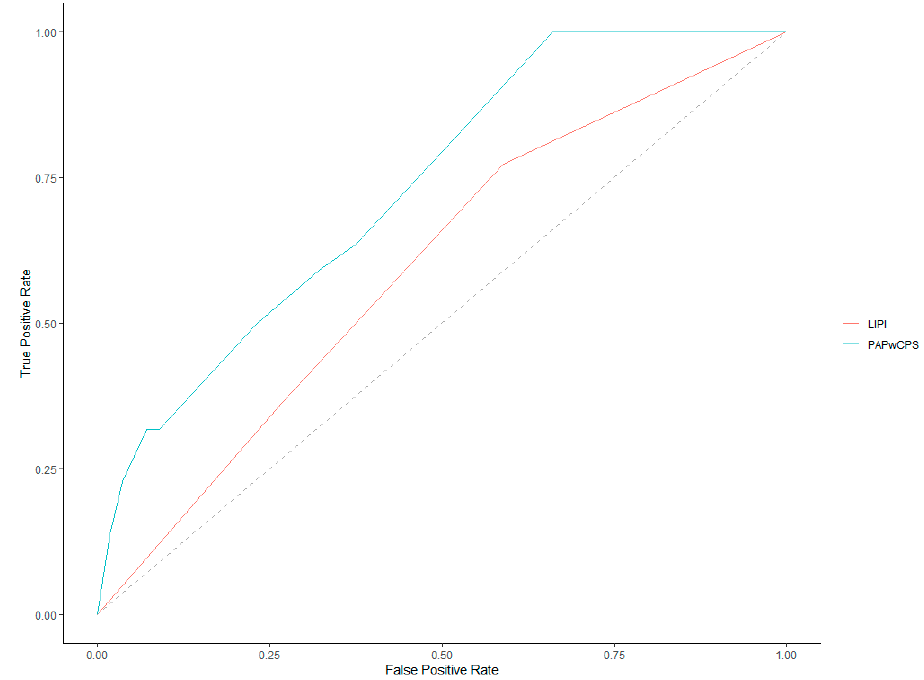
Figure 2. Receiver operating characteristics (ROC) curves for 30-day mortality.